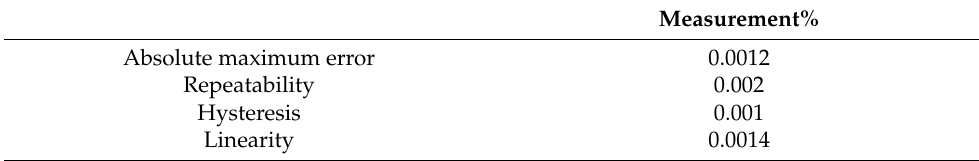
Table 3. Absolute maximum error, repeatability, hysteresis, and linearity of measured